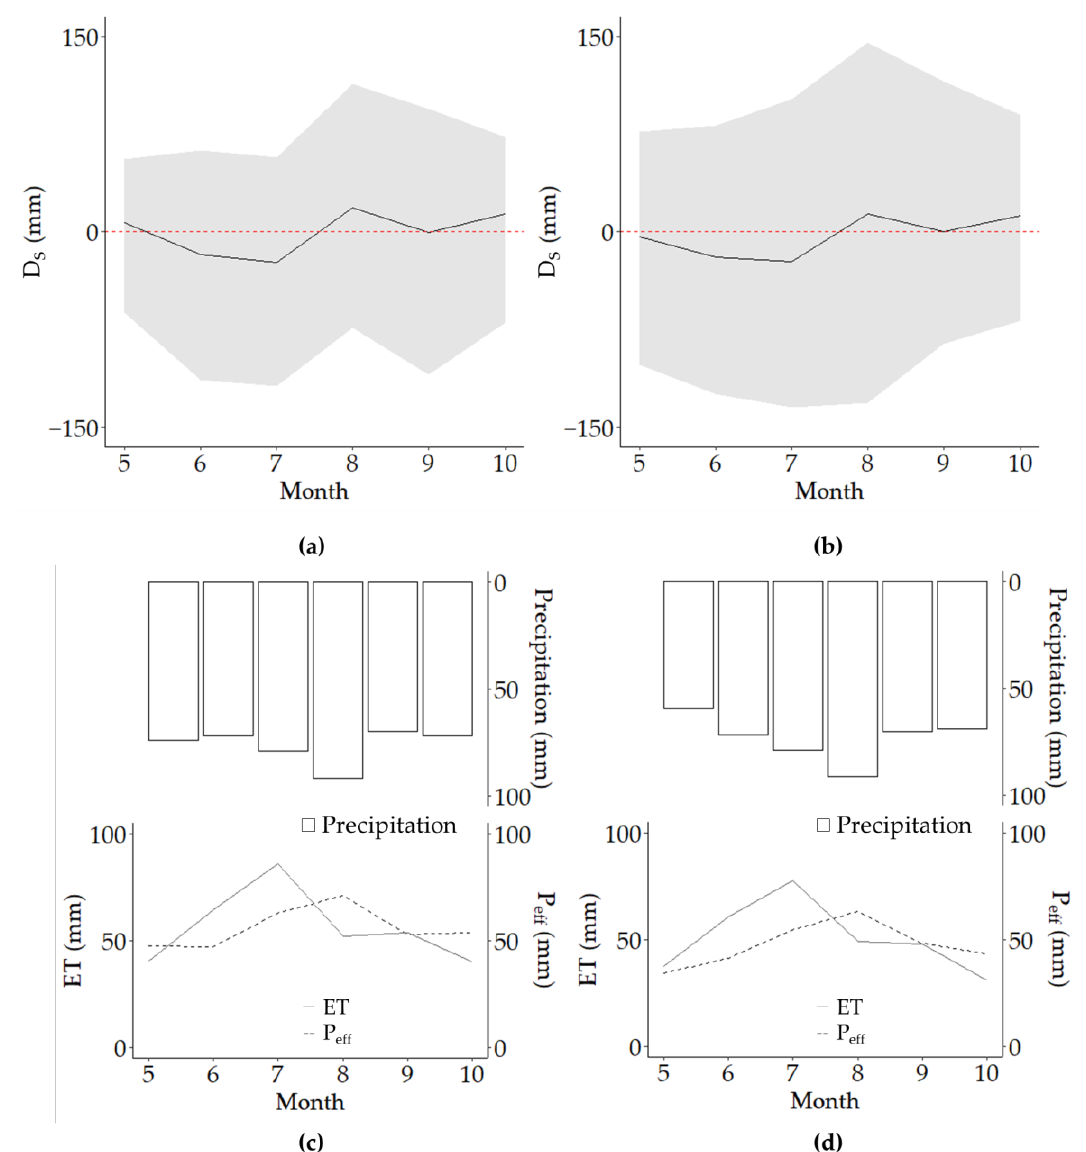
Figure 4. ( a ) Average monthly deficits ( − ve) and surpluses (+ve) for corn; ( b ) Average monthly deficits ( − ve) and surpluses (+ve) for soybeans; ( c ) Average monthly precipitation, effective precipitation (black dotted line), and evapotranspiration (grey solid line) for corn; ( d ) Average monthly precipitation, effective precipitation (black dotted line), and evapotranspiration (grey solid line) for soybeans. Shaded region indicates the range of distribution of the monthly D S across all years.